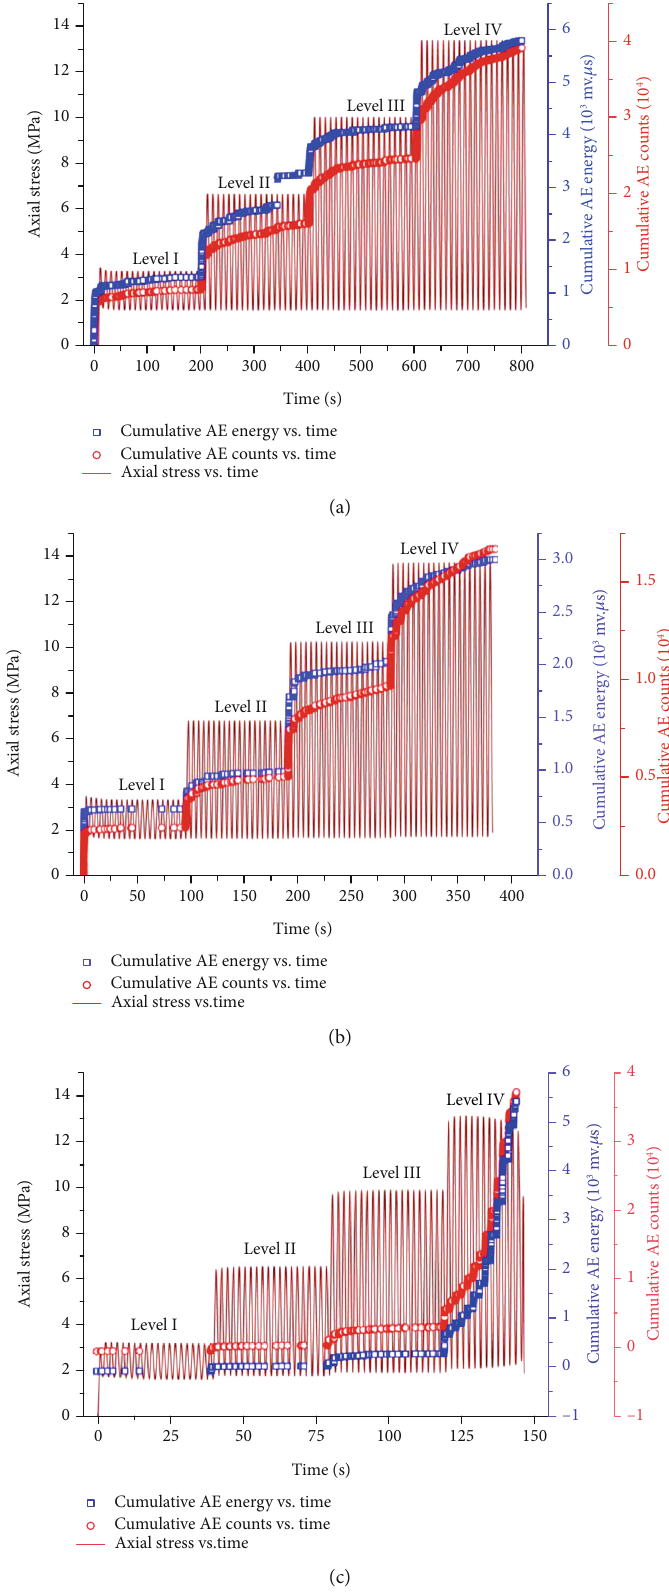
Figure 10: Evolution of axial stress and AE events of coal versus time at di ff erent loading frequencies: (a) 0.1Hz; (b) 0.2Hz; (c)